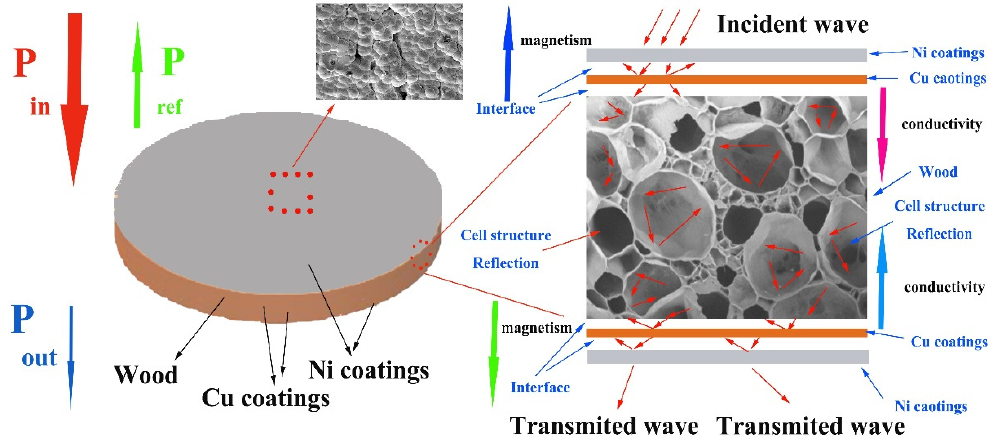
Figure 8. Process of multilayer coatings electromagnetic wave attenuation.